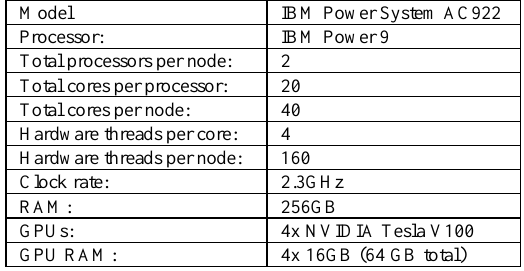
Table 01: Frontera Longhorn computing node configuration.